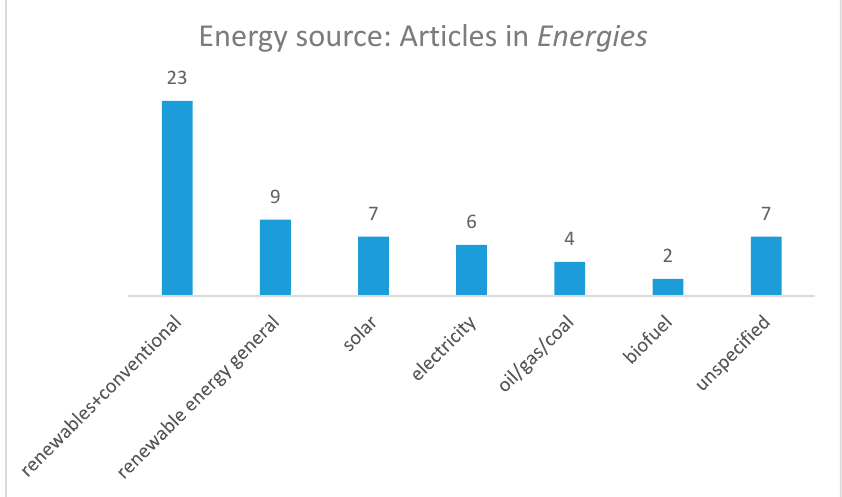
Figure 5. Number of articles in Energies by type of energy